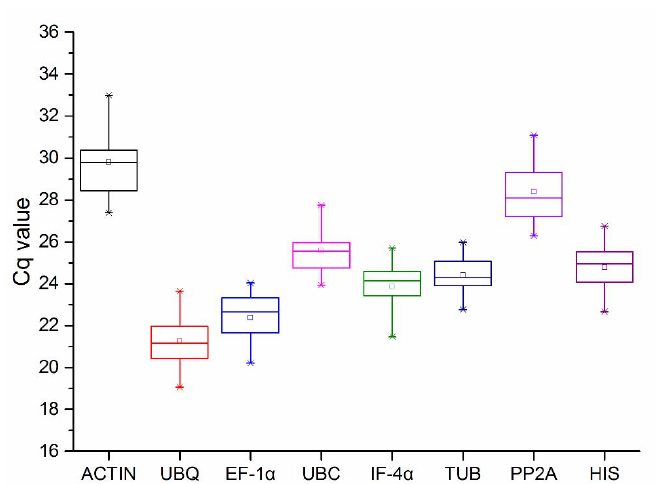
Figure 3. The Cq values of eight genes in all samples. The asterisk in the figure represents outliers, the line across the box represents median, the box represents a range of 25 to 75% in the value of Cq, and the extension lines at the top and bottom represent a range of 5 to 95%, with different levels of abundance for each reference gene transcript. Cq: quantification cycle.